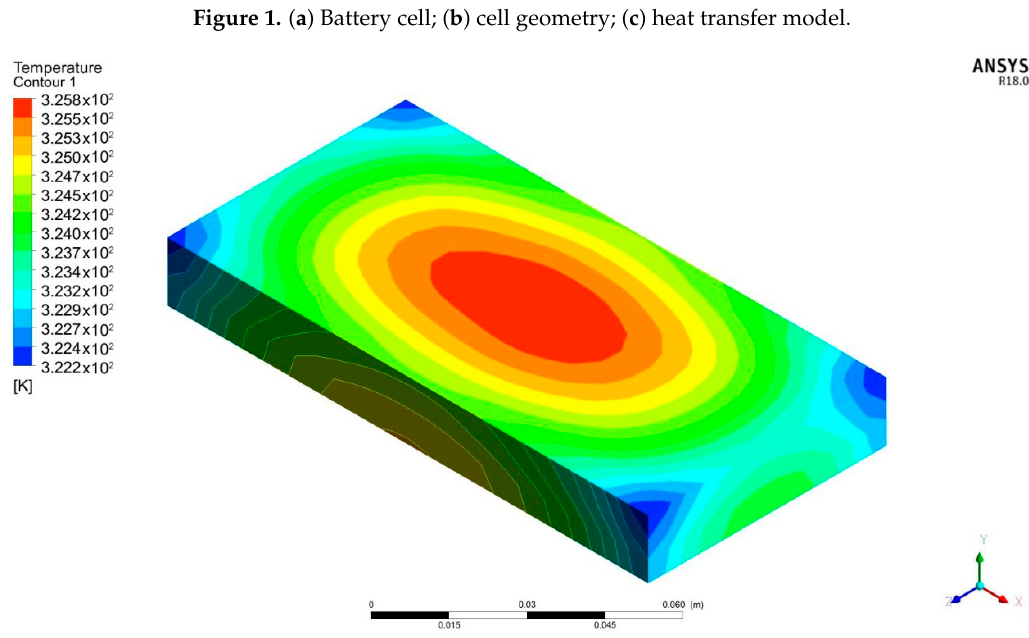
Figure 2. Surface Figure 2. Surface temperature.